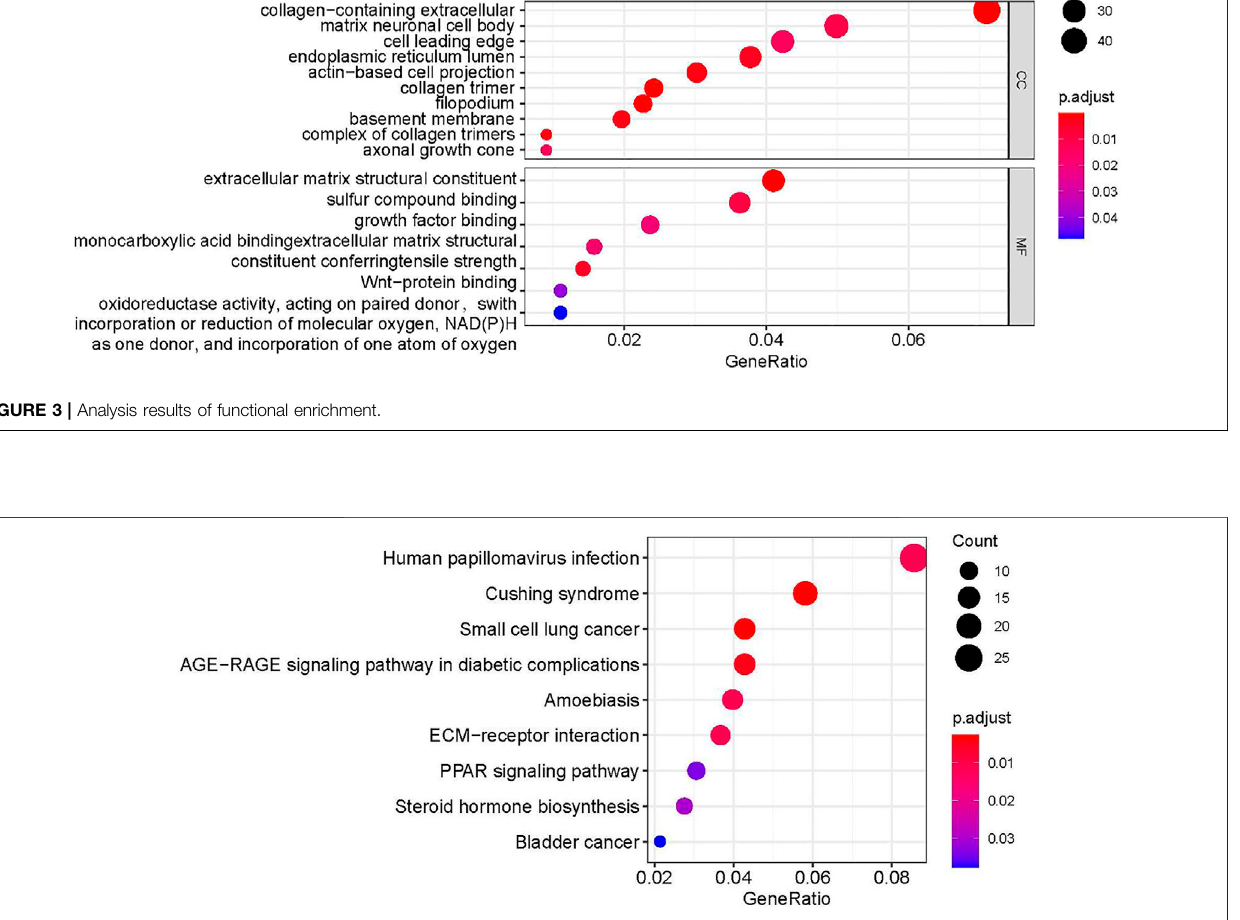
FIGURE 4 | Enrichment analysis by KEGG of DEGS.